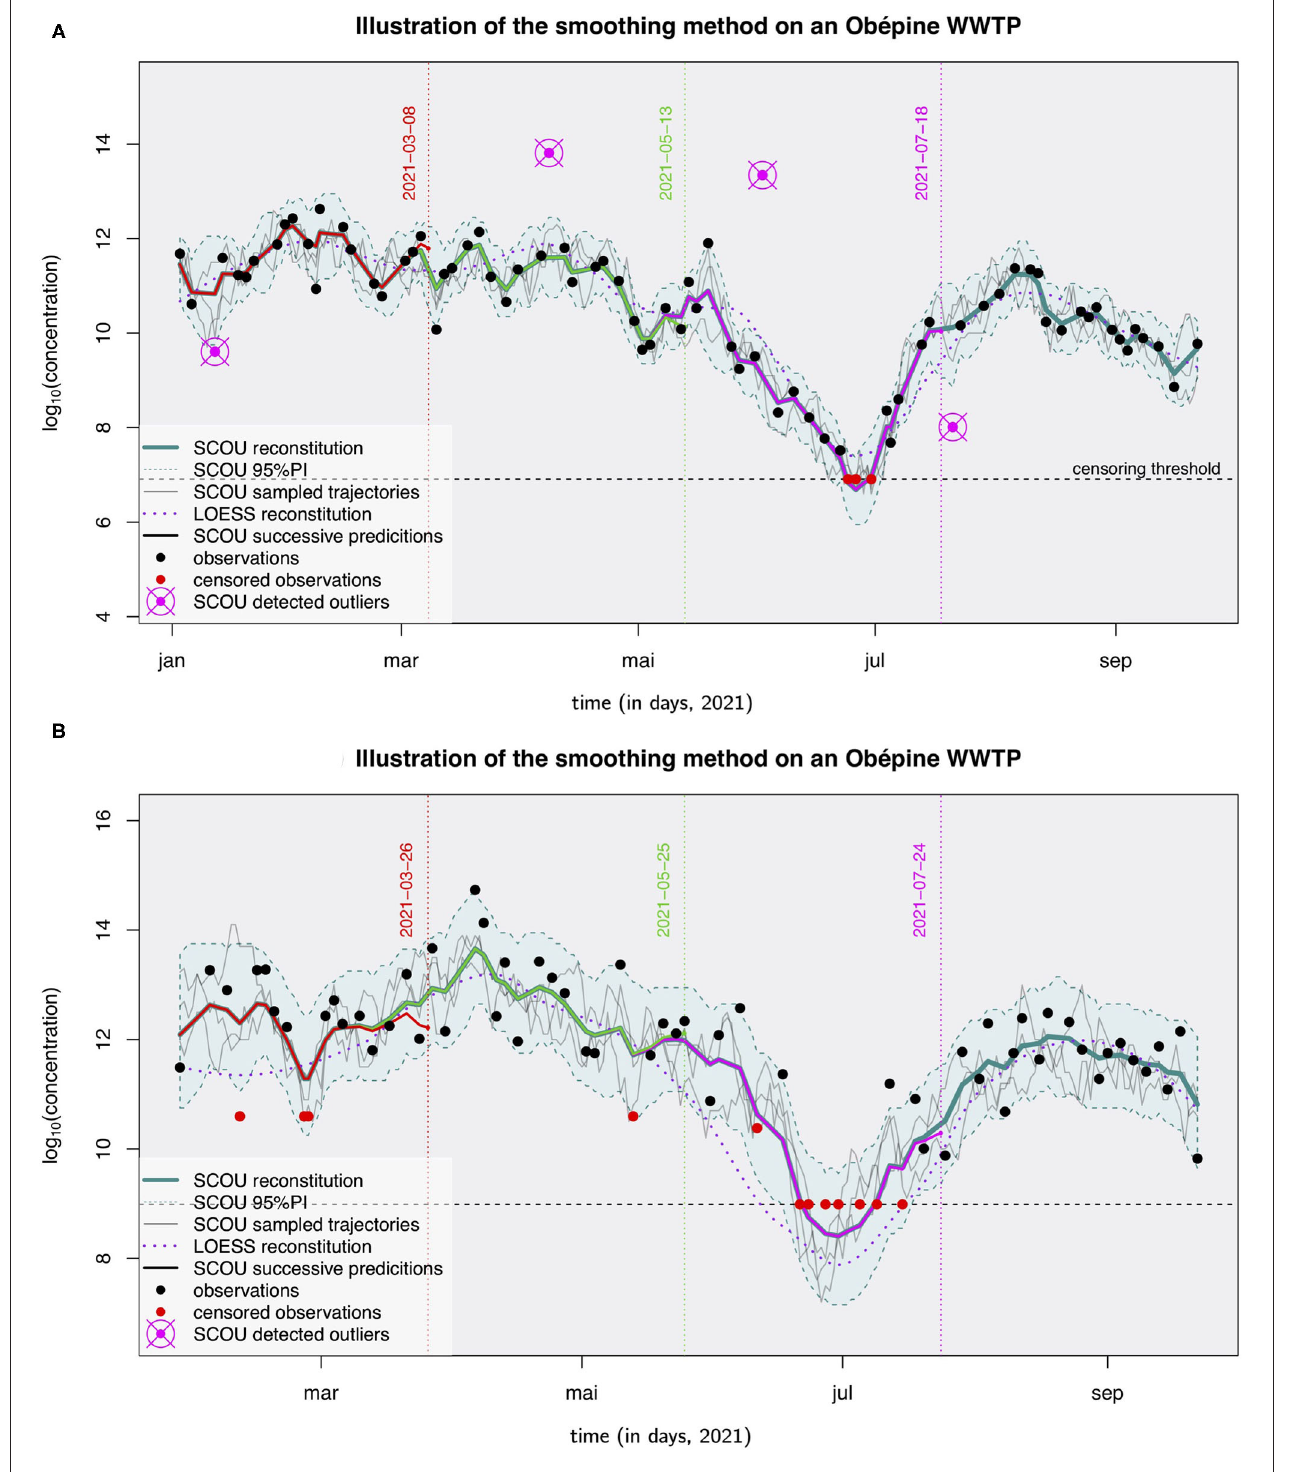
FIGURE 7 | (A) and (B) : Application of the LOESS (for a span parameters chosen by leave-one-out) and of the proposed smoother for two WWTPs of the Obépine network: examples of successive predictions for the (never observed) underlying signal, X , with the final parameters, 3 simulations of X according to the proposed model, 95 % prediction intervals for X , and outlier detection